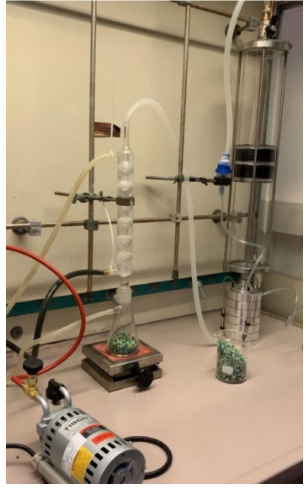
Figure 2. A test bacterial solution made of Staphylococcus aureus aerosol is released by a vacuum pump into a cascade